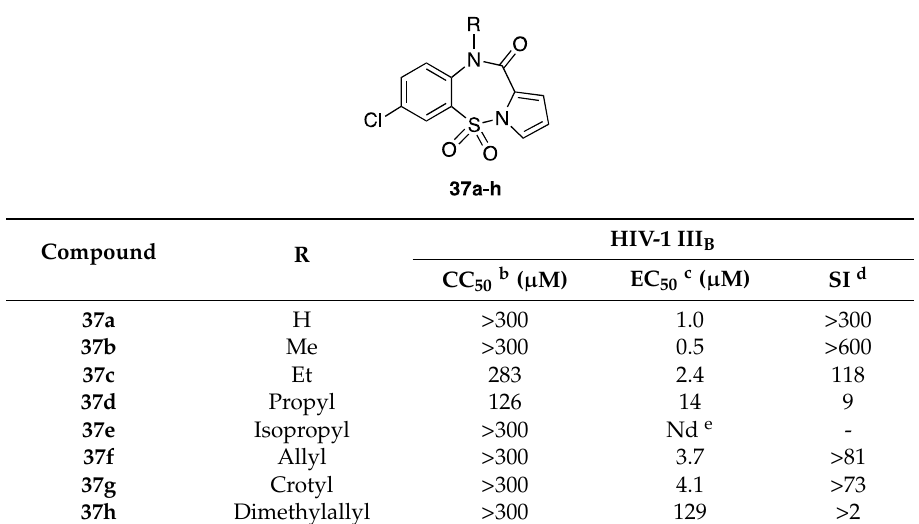
Table 1. Anti-HIV-1 activity of 7-Cl-PBTDs 37a – h a .